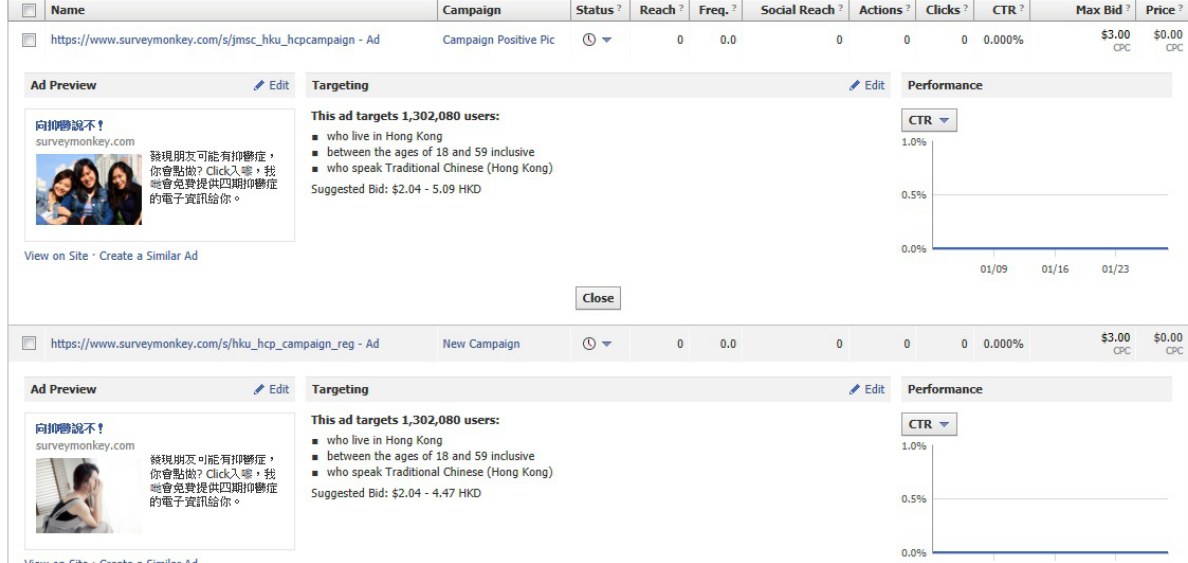
Figure 1. The happy and sad face images and their targeted Facebook users.